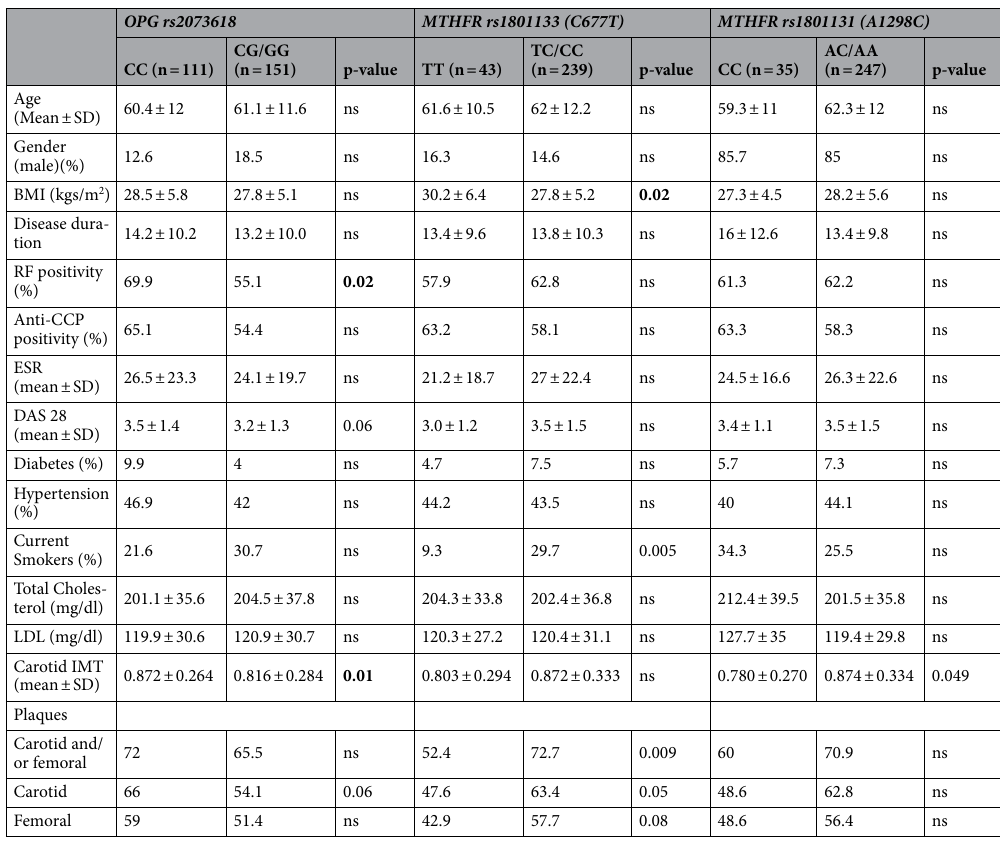
Table 2. Associations of osteoprotegerin (OPG) and methylene-tetrahydrofolate reductase (MTHFR) minor allele homozygous genotypes with demographics, disease related features, traditional CV risk factors and markers of subclinical atherosclerosis among rheumatoid arthritis (RA)